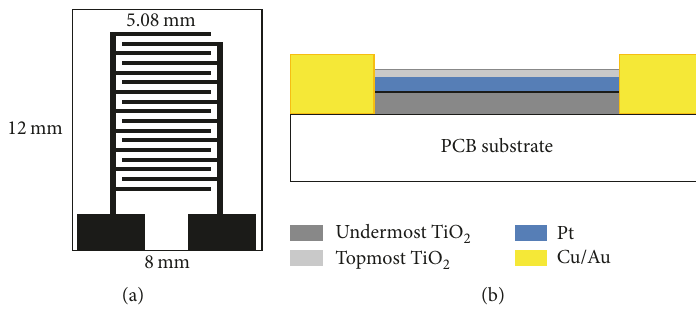
Figure 1: Schematic view of (a) PCB substrate and (b) TiO 2 /Pt/TiO 2 sandwich nanostructures on the PCB substrate.